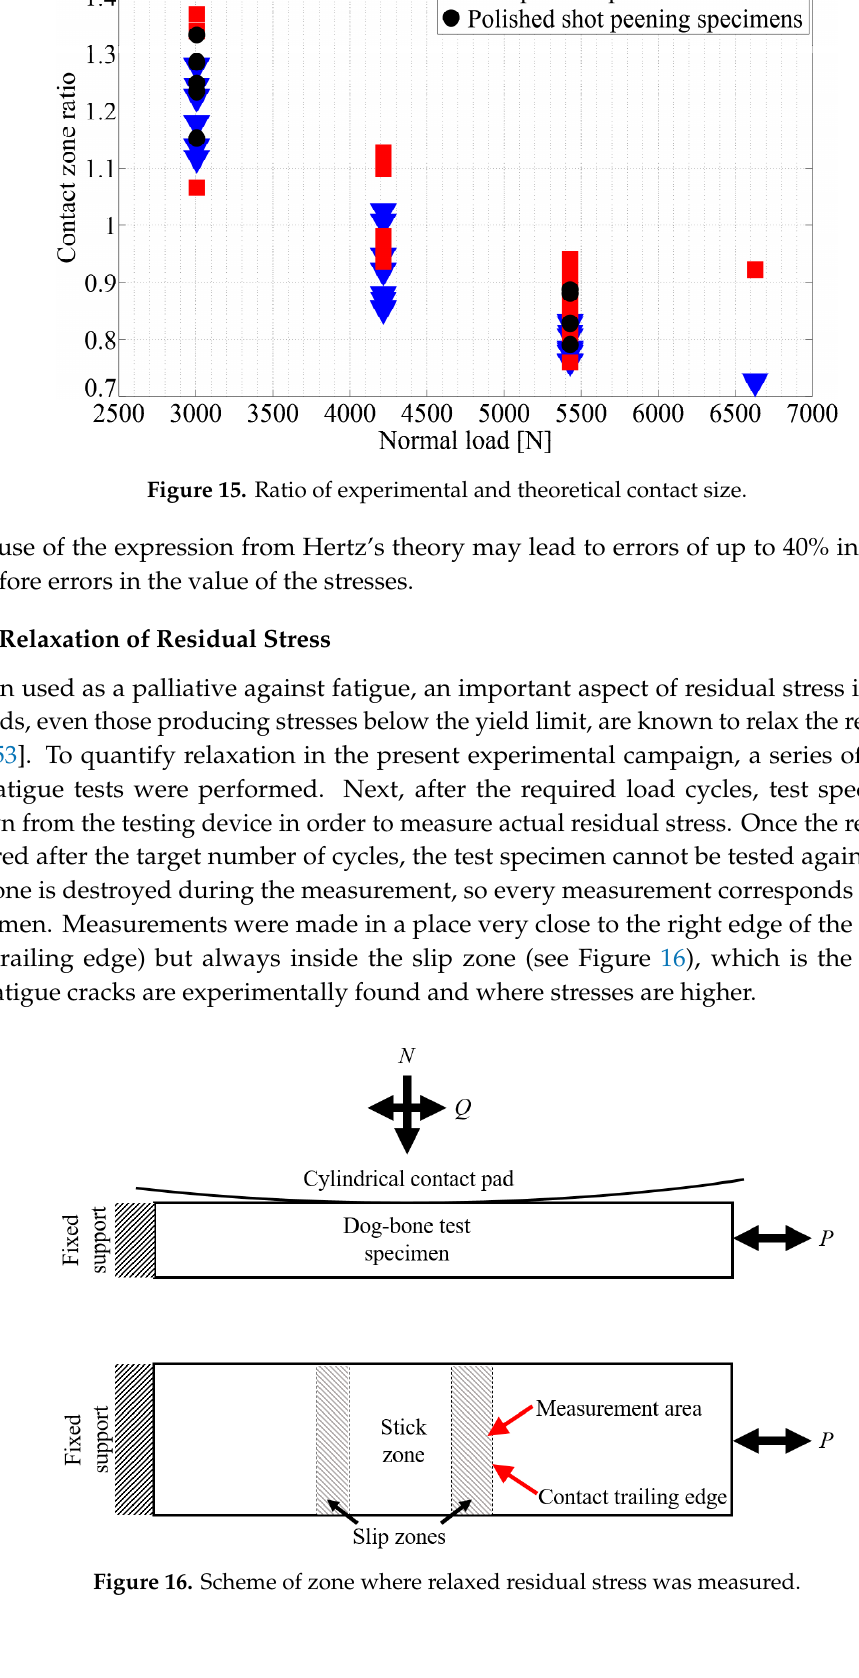
Figure 14. Total contact width in each test of each group and theoretical values given by Hertz’s theory.